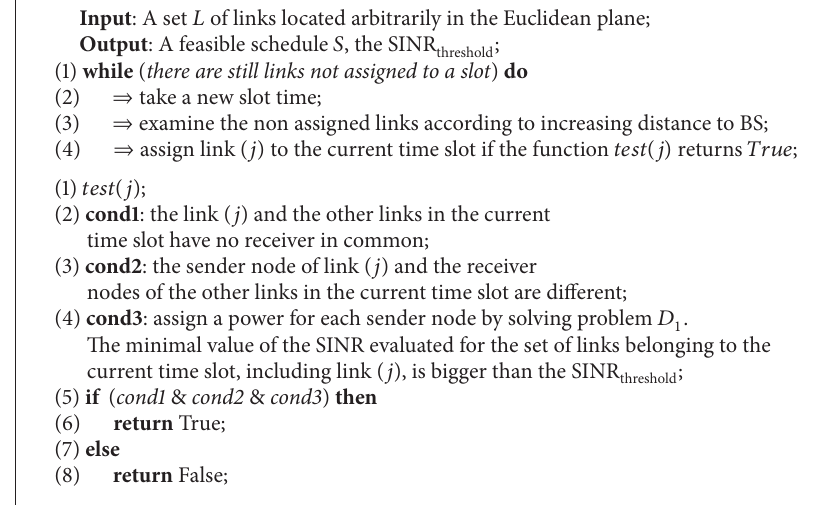
Algorithm 3: The principle of the algorithm for the JLSPA problem.